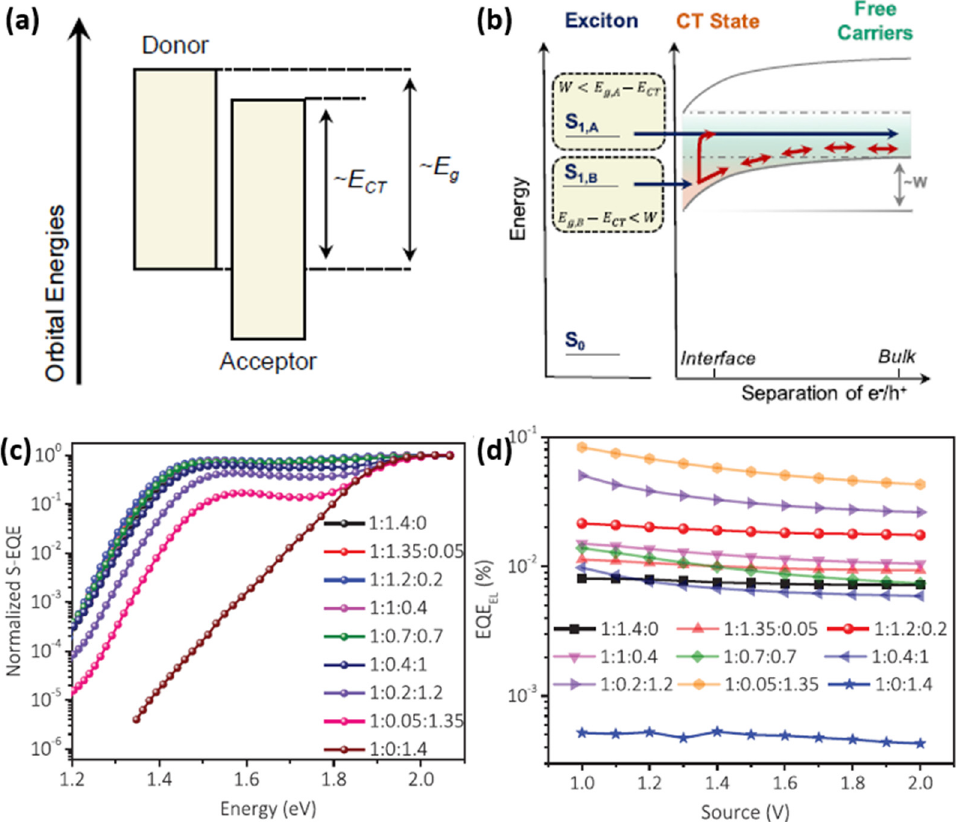
Figure 10. ( a ) Diagram of organic solar cell orbital energetics for a typical donor-acceptor pairing. ( b ) Schematic of two charge-generation pathways in systems with a large offset energy. Reproduced from [99]. ( c ) Normalized s-EQEs and ( d ) EQE EL values of the binary and ternary devices. Reproduced from [100].